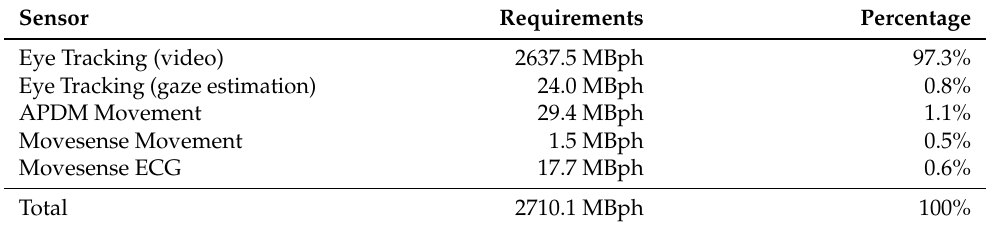
Table 3. Storage requirements over time per